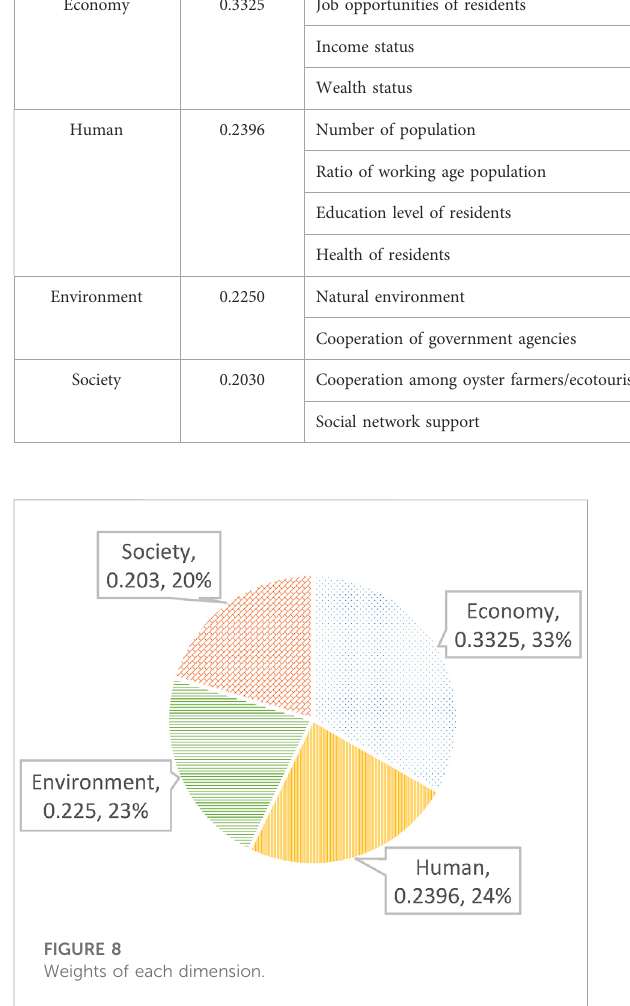
TABLE 4 Overall composite weights of each dimension and criterion by FAHP. Dimension